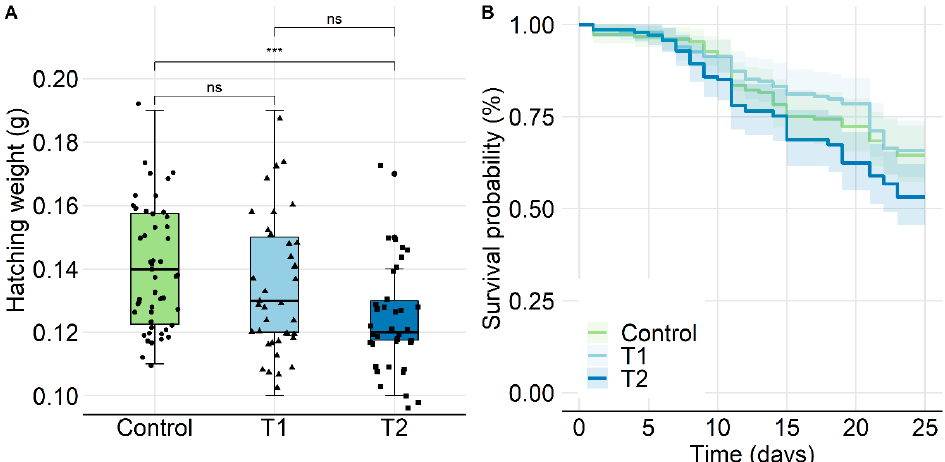
Figure 4. Effect of chronic GBH feeding exposure (T1: 4.8, T2: 137.6 mg a.i./kg) on hatching weight and survival of adult worker bees. ( A ) Hatching weight was assessed on the day of emergence after 24 h in the incubator and displayed as boxplot. Weight in T2 was significantly lower (16.7%) when compared to the control ( p < 0.01, Wilcoxon rank-sum test, pairwise). ( B ) Survival of individual workers is illustrated with a Kaplan–Meier survival curve and 95% confidence intervals. A pairwise comparison with corrections for multiple testing did not confirm differences between the respective treatments and the control ( p > 0.05, log-rank test, pairwise).